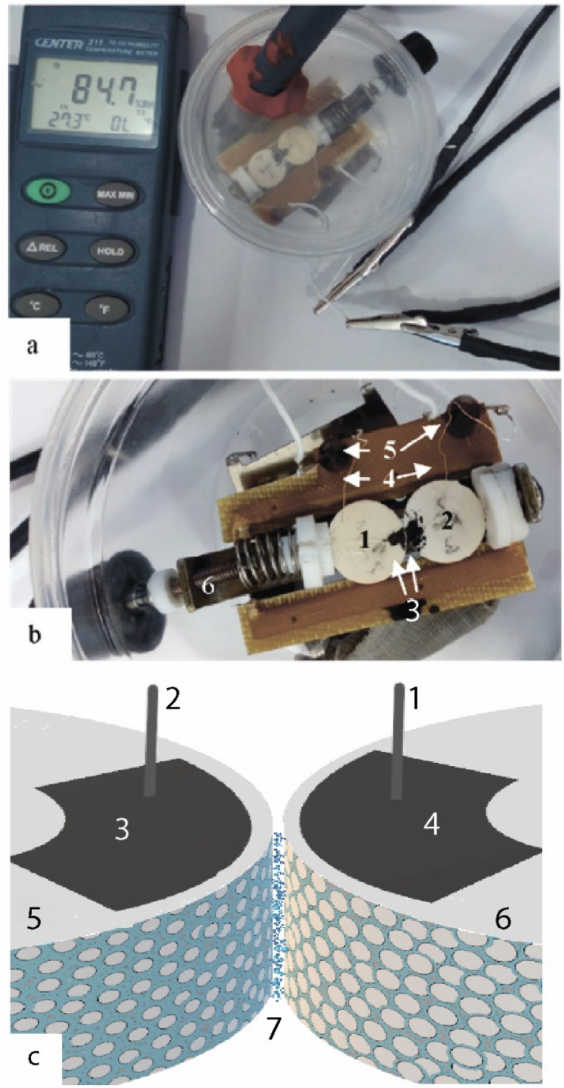
Figure 1. External view of the sample chamber ( a ), and the sample holder ( b ), where 1, 2—the tablets under study; 3—contact pads; 4—current collectors; 5—fixing racks; 6—mechanical spring-loaded clamp with adjustable force. The scheme of the experiment ( c ), where 1—anode; 2—cathode; 3, 4—contact pads; 5—a tablet of a powder with a smaller particle size, 6—a tablet of a powder with a large particle size, 7—a hydration